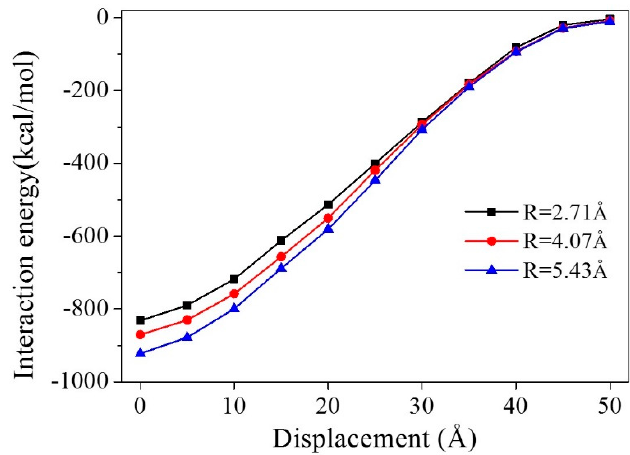
Figure 4. Interaction energies of graphene and a polymer matrix in composite models with different CNT radii during the pullout process.